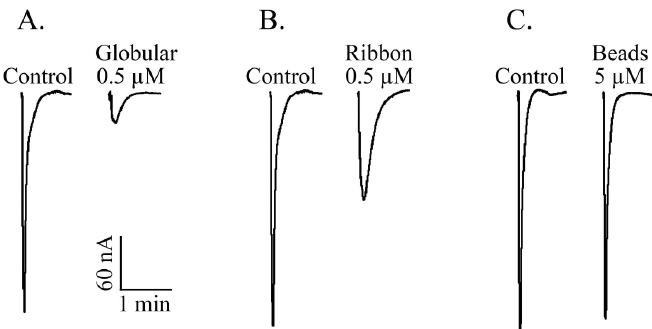
Figure 7. Representative ACh-evoked currents of rat α 3 β 2 nAChRs expressed in Xenopus oocytes obtained in the absence (Control) and presence of 3 isomers of α -CTx TxIA.